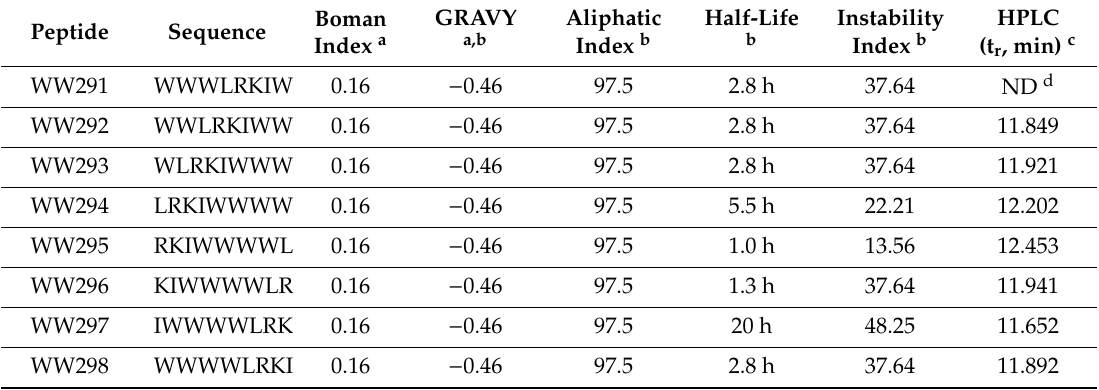
Table 1. Amino acid sequences, calculated properties and measured HPLC retention times of sequence permutated peptides